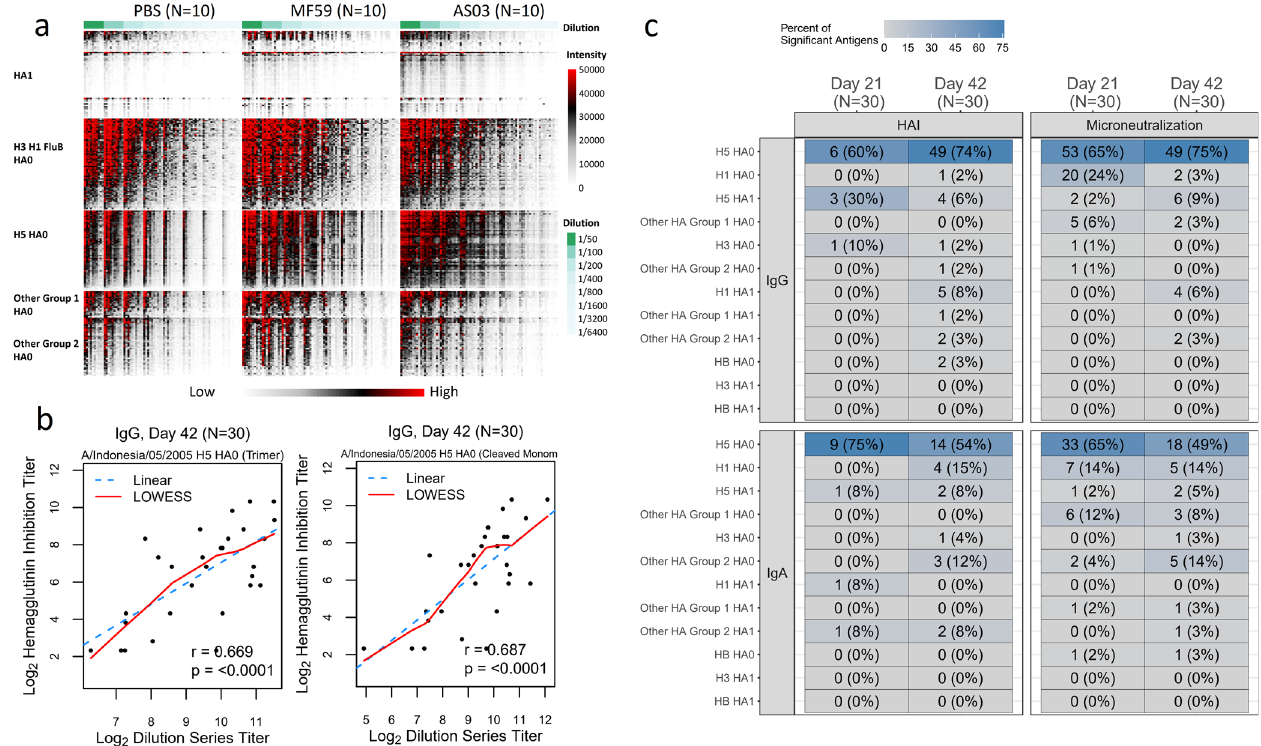
Fig. 10 Array-based titers determined in an 8 dilution-series experiment for vaccine antigens and antigens belonging to the same subtype as the vaccine antigen were signi fi cantly correlated with HAI and microneutralization titers. a Array results for eight dilutions for 60 sera. b Scatter plots of day 42 log 2 dilution series-based titer and log 2 hemagglutinin inhibition and log 2 microneutralization titer for in fl uenza A/Indonesia/05/2005 antigens across vaccine groups ( n = 30) for HA0 trimer (left) and cleaved monomer (right). c The number and percentage of antigens with statistically signi fi cant Pearson correlations ( p < 0.05) by assay, molecule, and